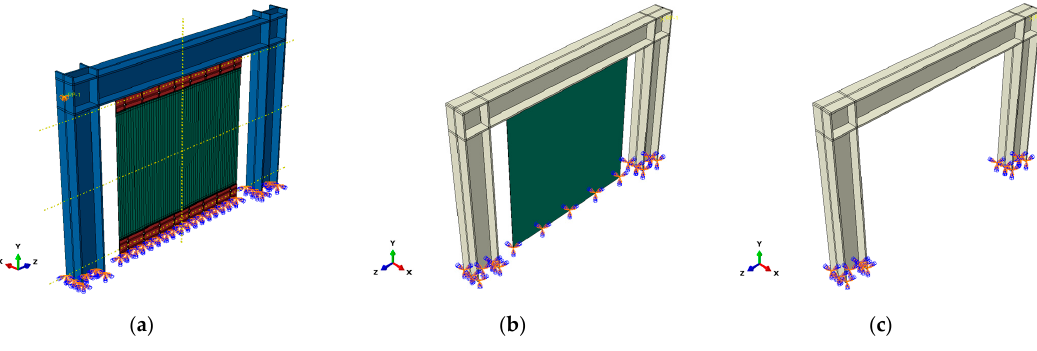
( d ) Figure 8. Construction details of the models used for performance analysis: ( a ) upper part of the bolt connection of the steel plate; ( b ) lower part of the bolt connection of the steel plate; ( c ) transi-